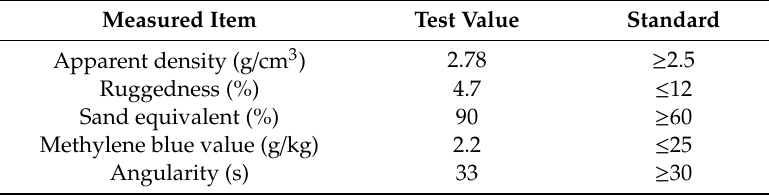
Table 3. Technical properties of fine aggregate.